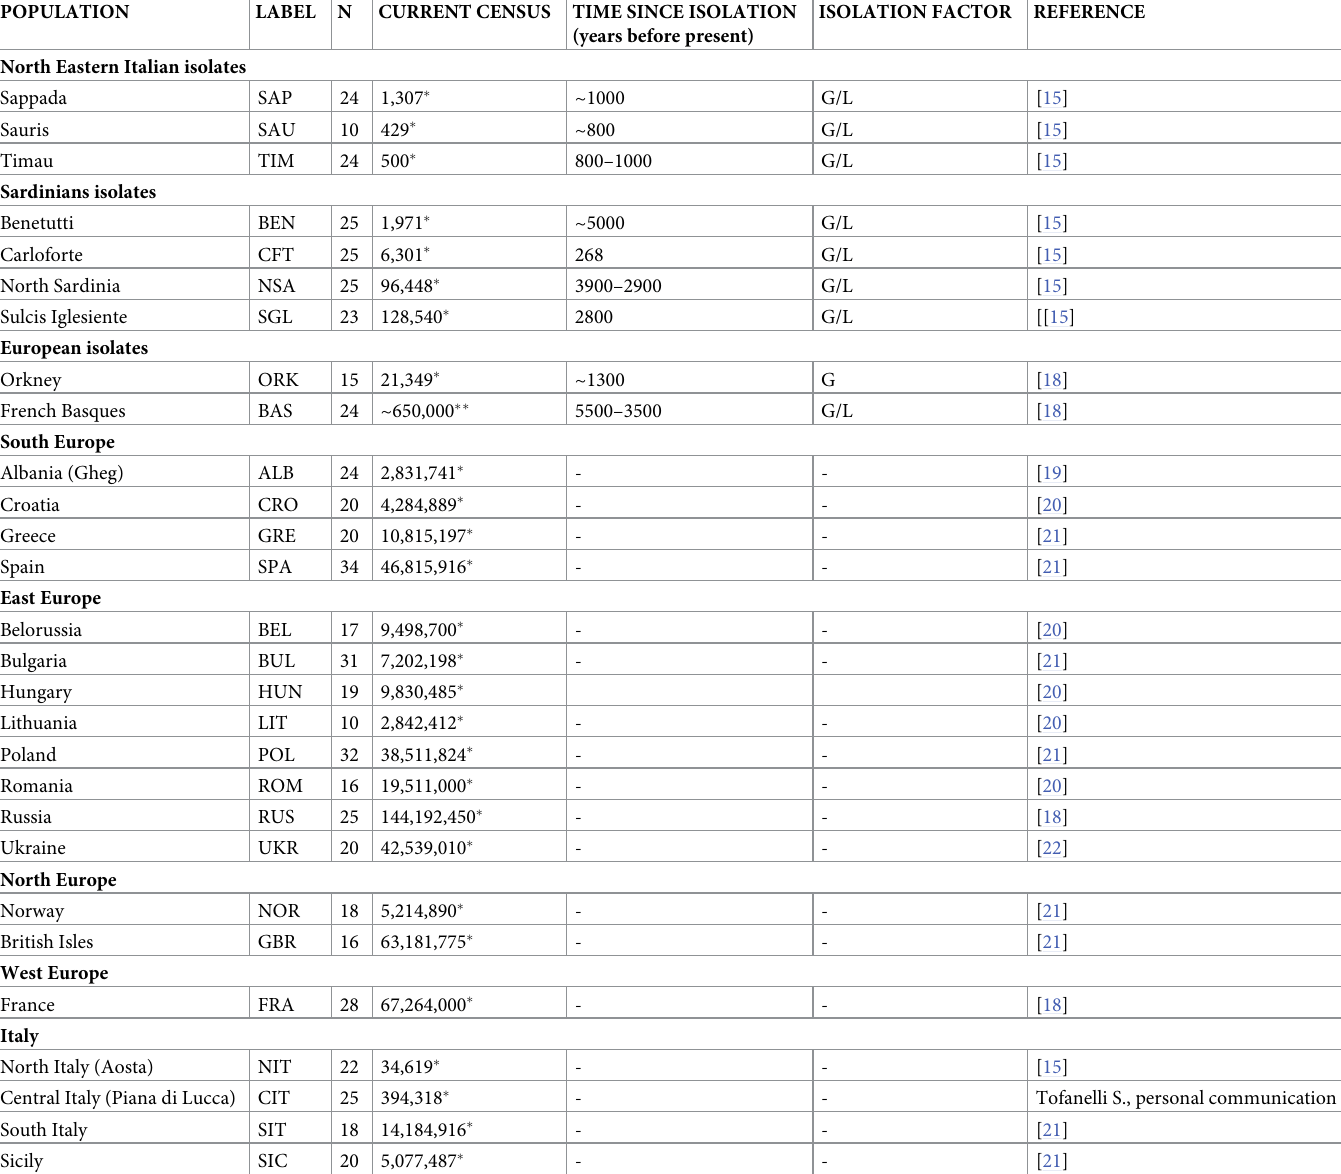
Table 1. Demographic information about the populations under study. POPULATION LABEL N CURRENT CENSUS TIME SINCE ISOLATION